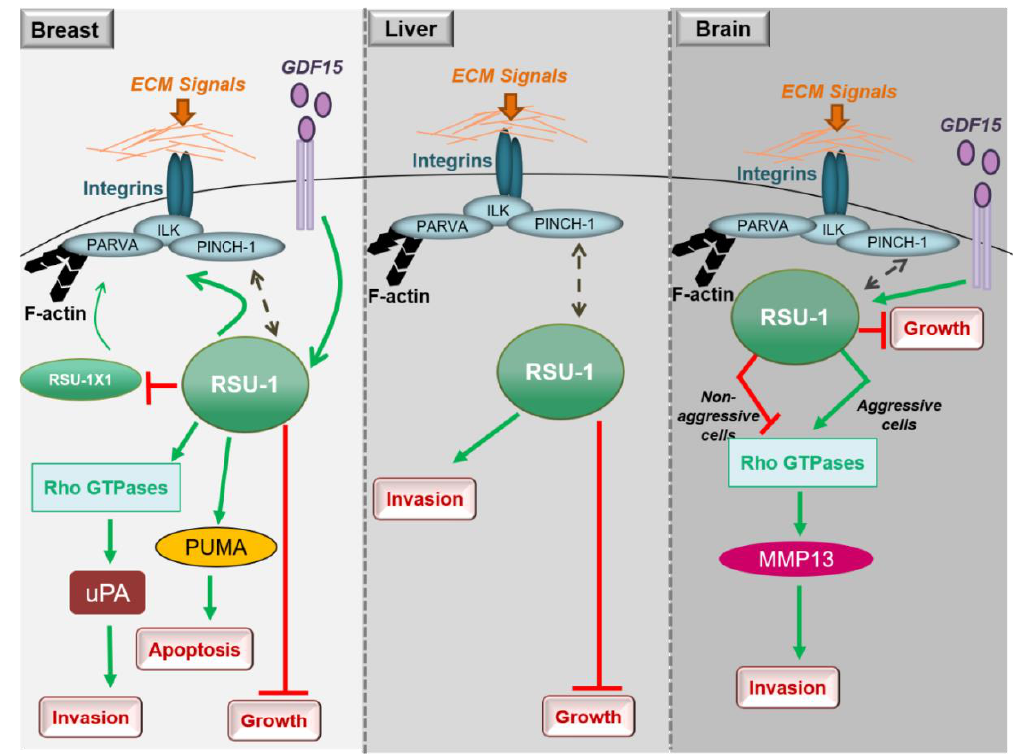
Figure 2. Diagrammatic representation of the role of RSU1 with regard to the cancer-related properties of breast, liver and brain cancer cells.